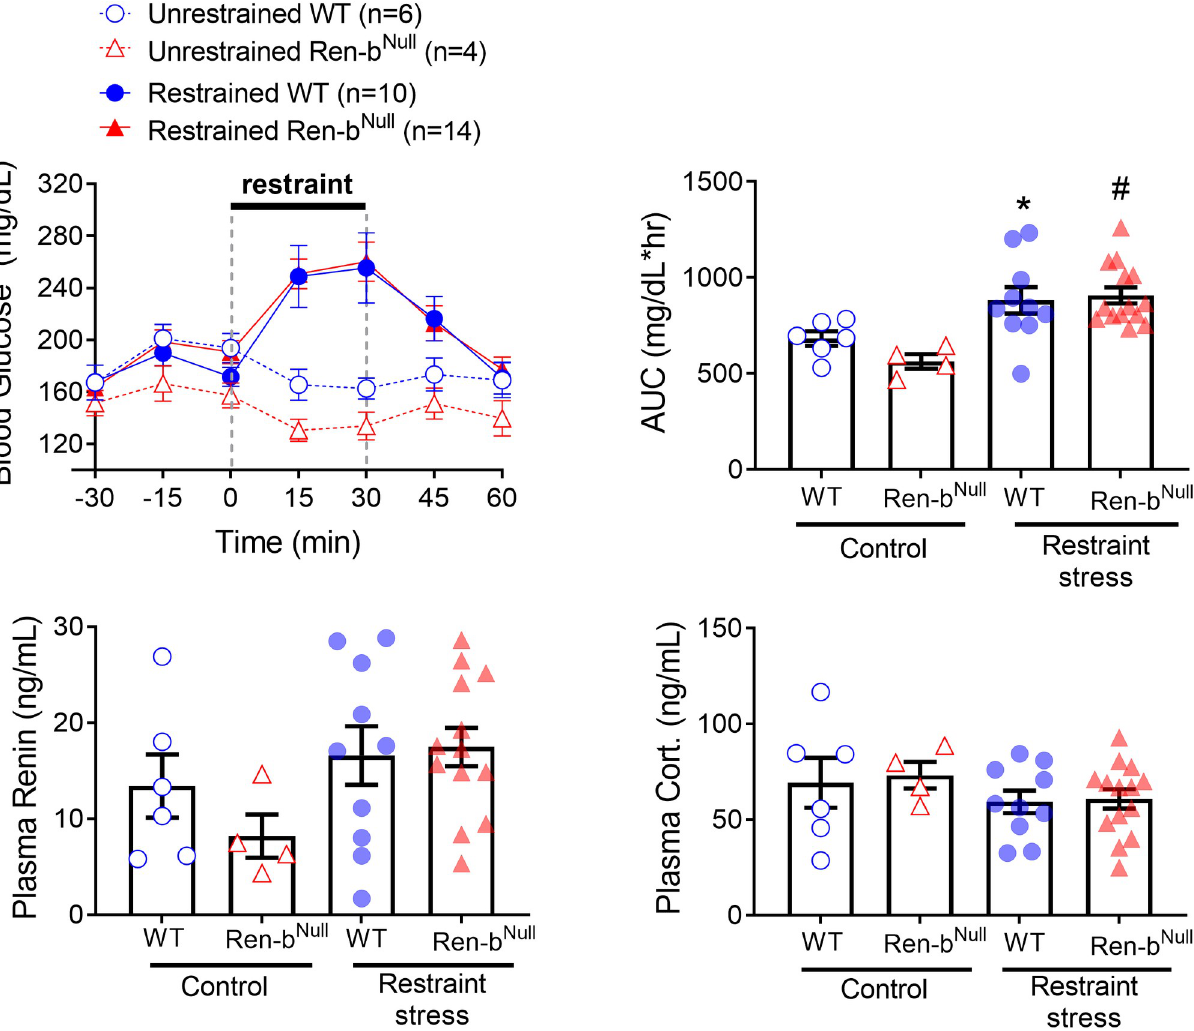
Fig 7. A) Blood glucose was determined every 15 minutes before, during, and after restraint-stress in Ren-b Null and wildtype littermates (WT) males and females. A group of unrestrained Ren-b Null and WT controls, which were kept in their home cages was included. B) The area under the curve (AUC) was calculated and the individual values were plotted. By the end of the protocol the animals were decapitated, and trunk blood was collected for renin (C) and corticosterone (D) determinations. � P < 0.05 vs unrestrained WT and # P < 0.05 vs unrestrained Ren-b Null